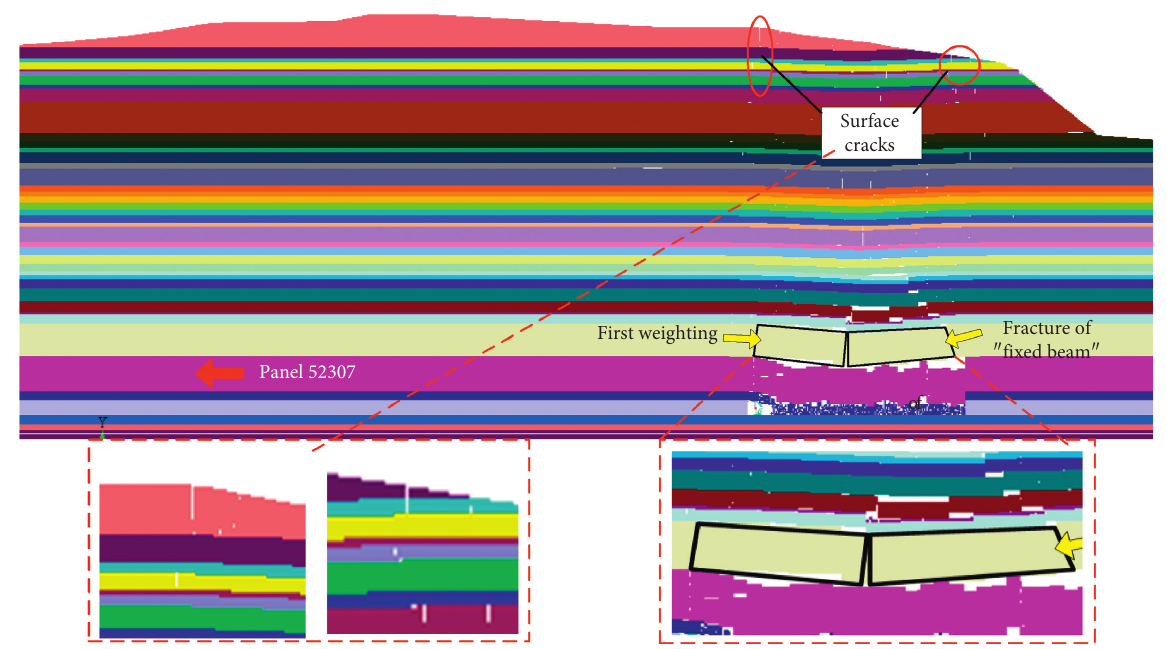
Figure 14: Initial weighting of working